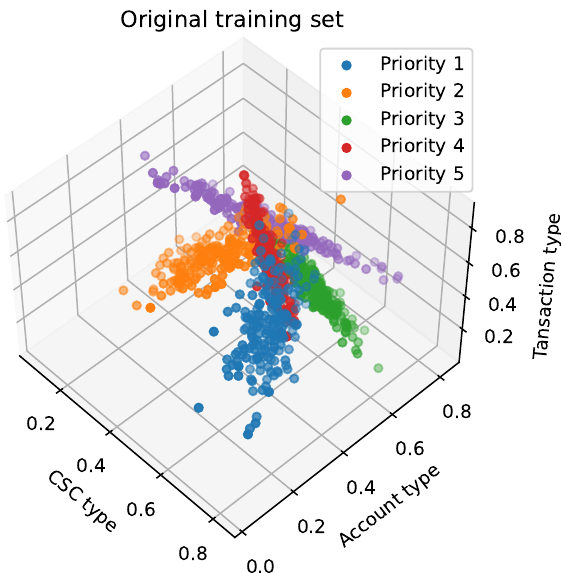
Figure 10. Original training set scatter